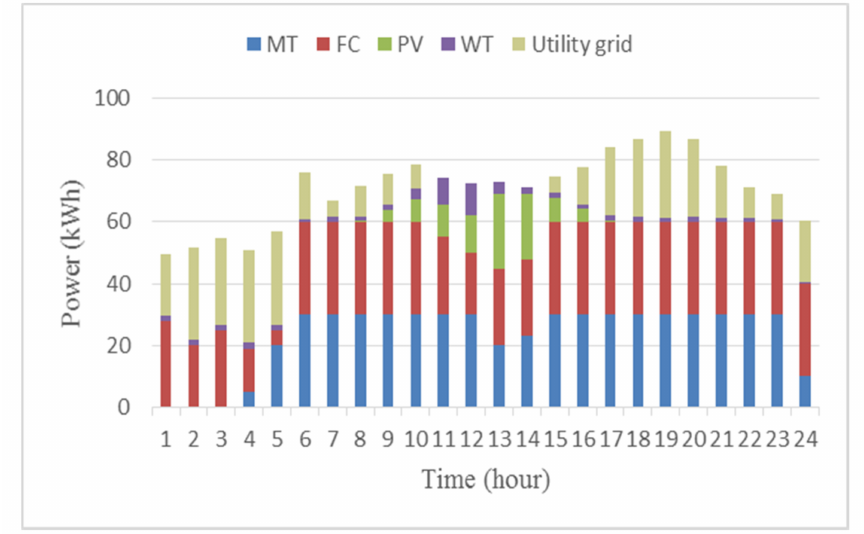
Figure 9. Optimal output of the generation sources obtained by GWO for Scenario